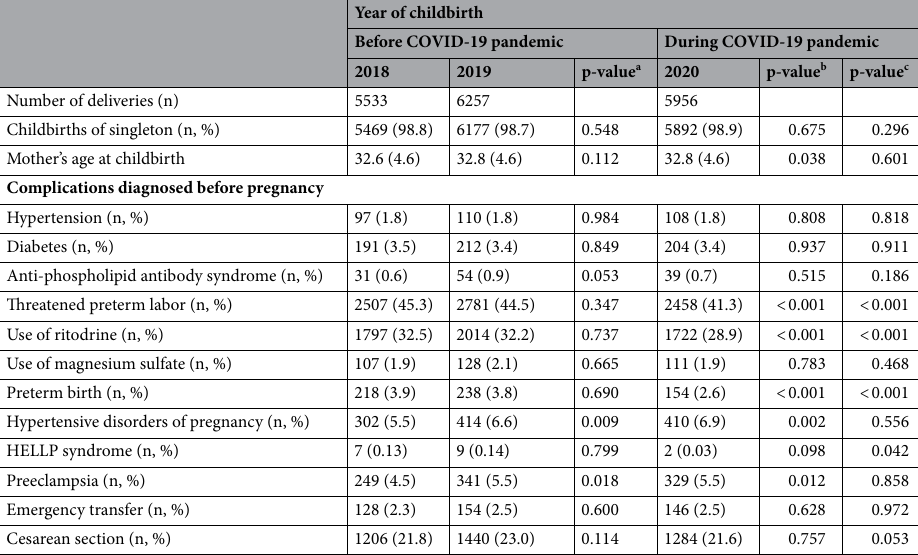
Table 1. Maternal characteristics and complications during pregnancy among the 17,746 deliveries in the years 2018, 2019, and 2020. The denominator for the percentage is the number of deliveries. Mother’s age at childbirth is presented as mean (standard deviation). P-values of Pearson’s chi-square test or Student’s t-test a: between 2018 and 2019, b: between 2018 and 2020, and c: between 2019 and 2020 are shown. We used a P value of 0.0167 to indicate significance to correct for